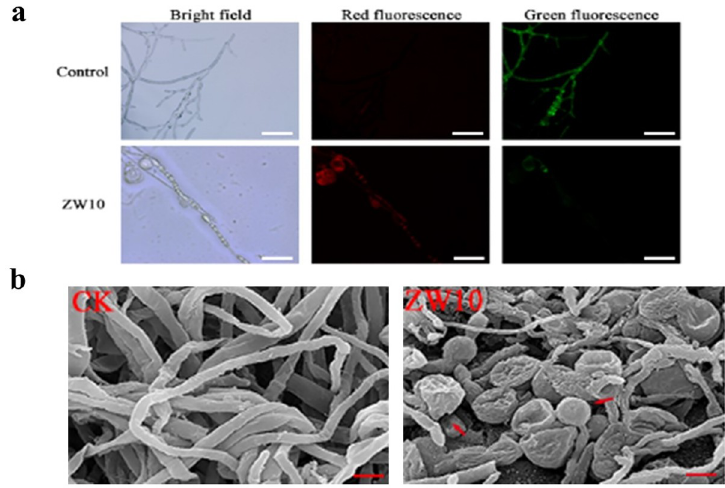
Fig 3. The effect of the antifungal substances of ZW10 on M . oryzae membrane permeability and mycelium morphology. After the treatment with 1% CFB of ZW10, the permeability of cell membrane was observed by FDA-PI staining (a), and the morphological structure of mycelium was observed by scanning electron microscopy (b). Scale bar in (a): 10 μ m, and (b): 5 μ m.